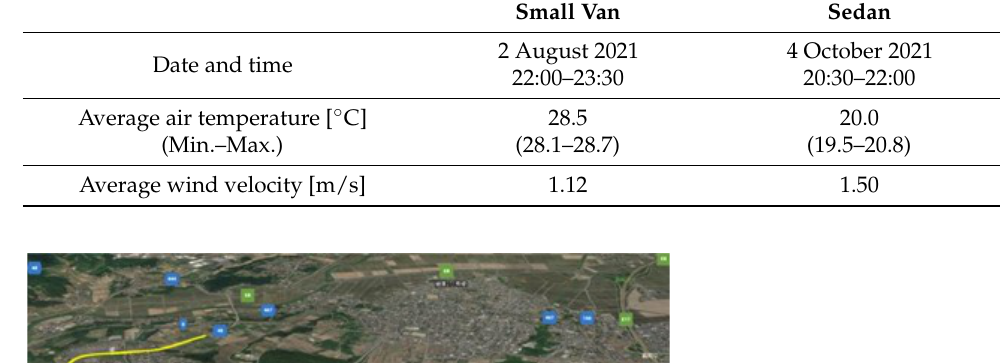
Figure 3. Driving route (Nagaoka city, Niigata, Japan). Table 1. Specifications of the sensors used.